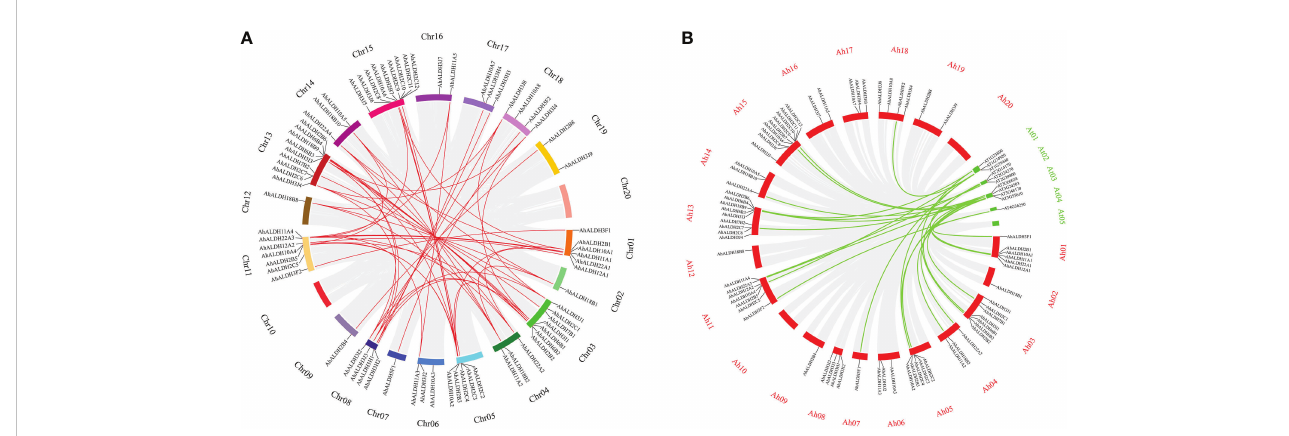
FIGURE 6 Collinear analysis of AhALDH members in groundnut and Arabidopsis . (A) Collinear analysis of AhALDH members in Arachis hypogaea. The circles of different colors represent different chromosomes, while red lines represent collinear pairs in AhALDH s, and a gray background represents all collinear blocks. (B) Collinear analysis of AhALDH s with Arabidopsis members. The red circles represent groundnut chromosomes, while green circles represent Arabidopsis chromosomes, and the green lines represent collinear gene